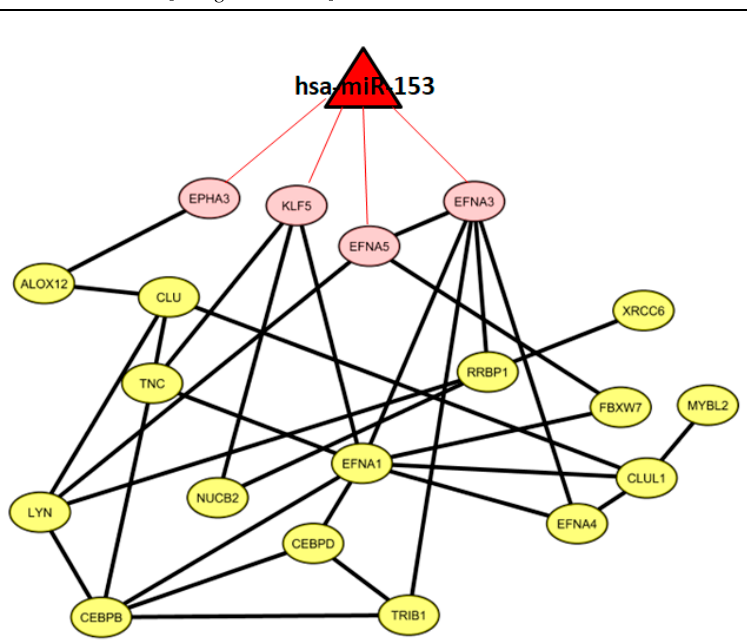
Figure 3. Gene co-expression network and putative miRNA-regulated targets.